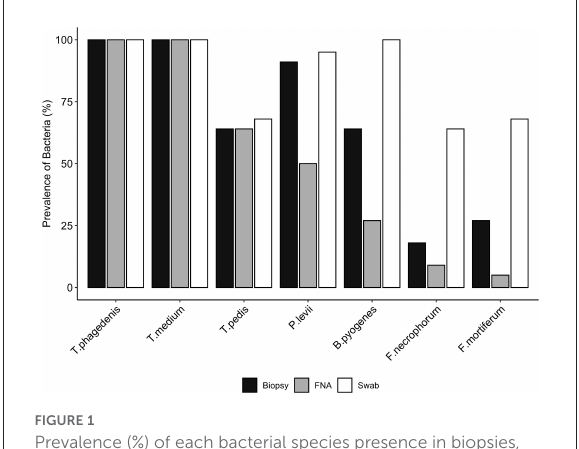
FIGURE1 Prevalence (%) of each bacterial species presence in biopsies, swabs, and fine-needle aspiration (FNA) from M2 DD lesions detected by qPCR. A McNemar’s test indicated significant differences in the proportions of the presence of Bacteroides pyogenes, Fusobacterium mortiferum , and Fusobacterium necrophorum between biopsies and swabs, and Porphyromonas levii , Bacteroides pyogenes, and Fusobacterium mortiferum between biopsies and aspirates ( p < 0.01); however, no significant difference was observed for the other